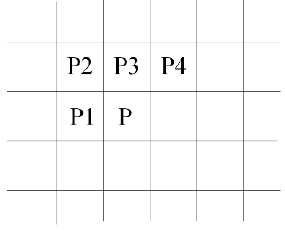
Figure 4. 8-connectivity pixel mask.